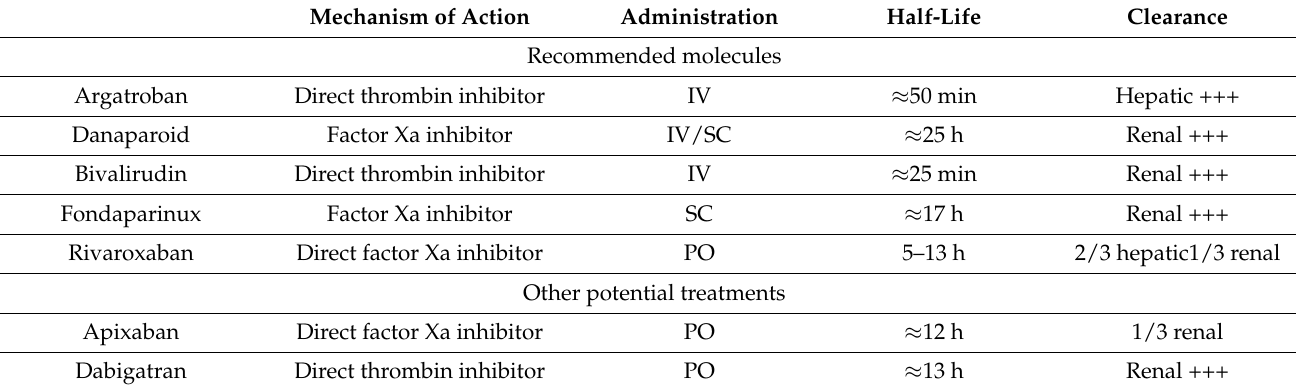
Table 3. Proposed molecules as treatment for heparin-induced thrombocytopenia. Mechanism of